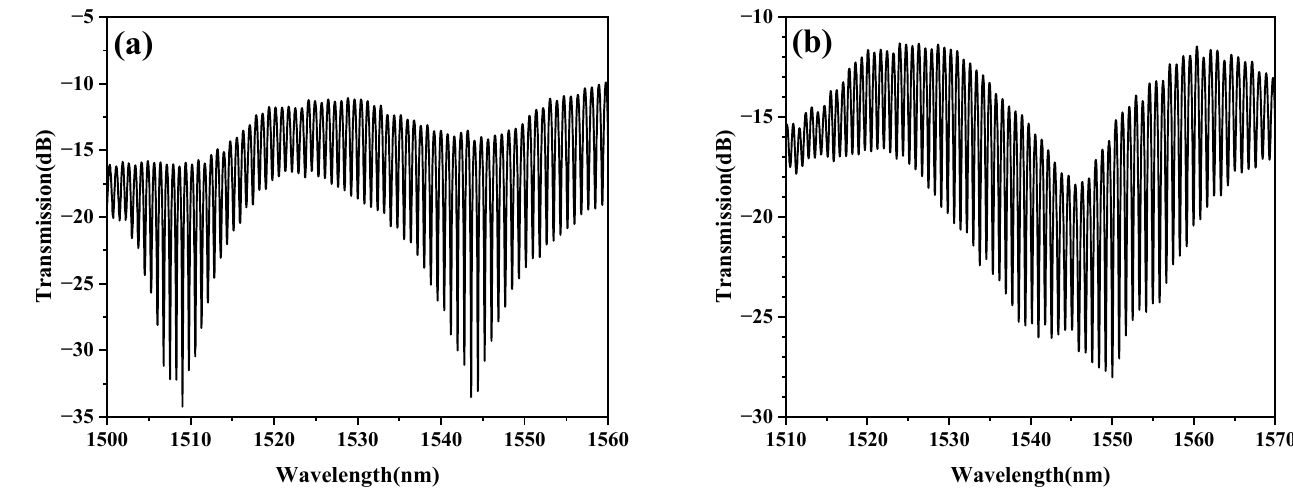
Figure 5. Measured transmission spectra of the composite filter at different PC angles: ( a ) small angle,